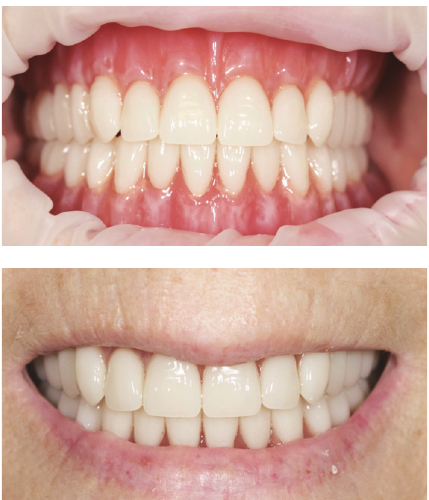
Figure 13: Clinical photos of the final